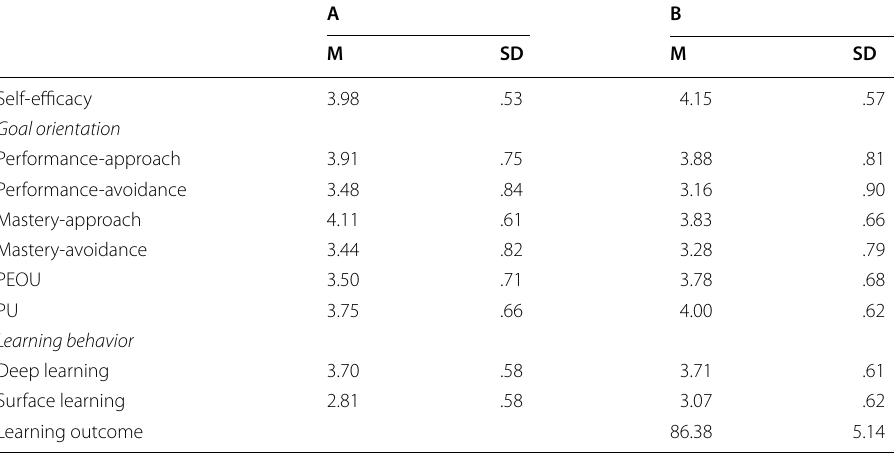
Table 5 Paired sample T test of variables from time point A to B Time point M SD t df p Self-efficacy A 3.98 .57